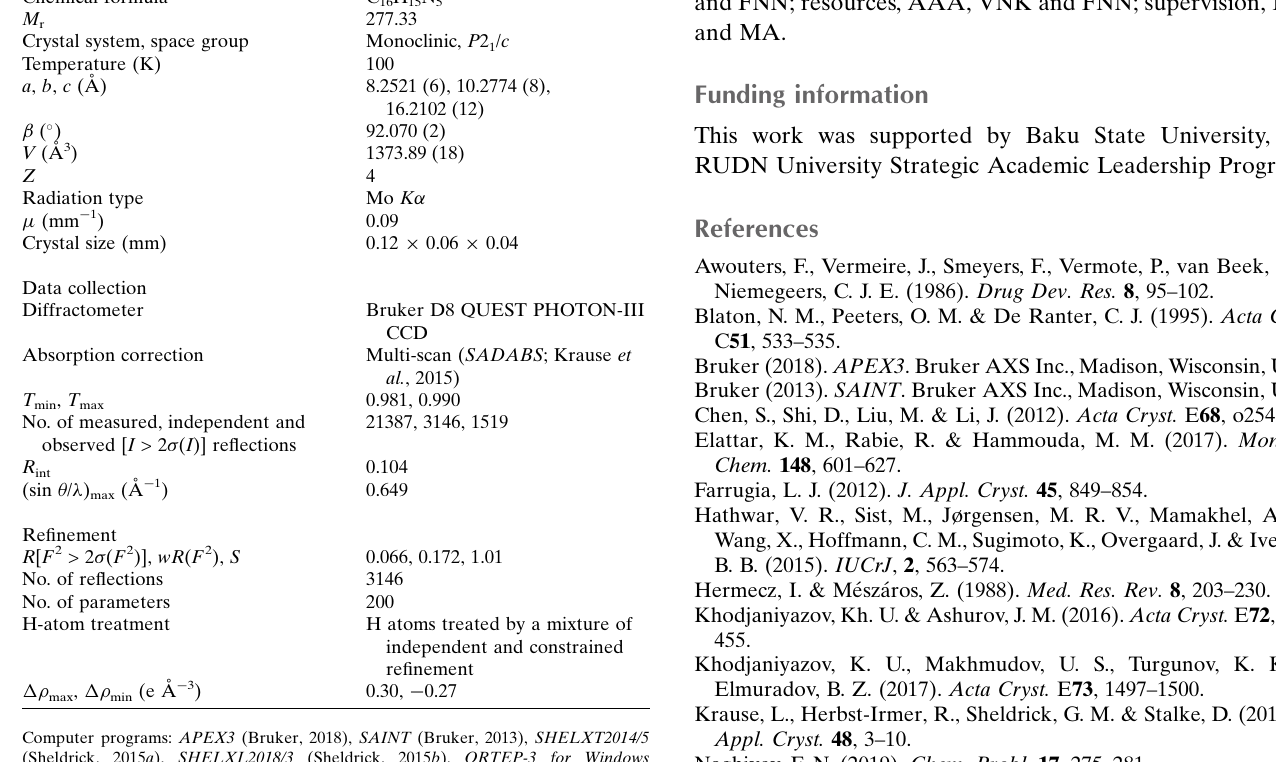
Crystal data Chemical